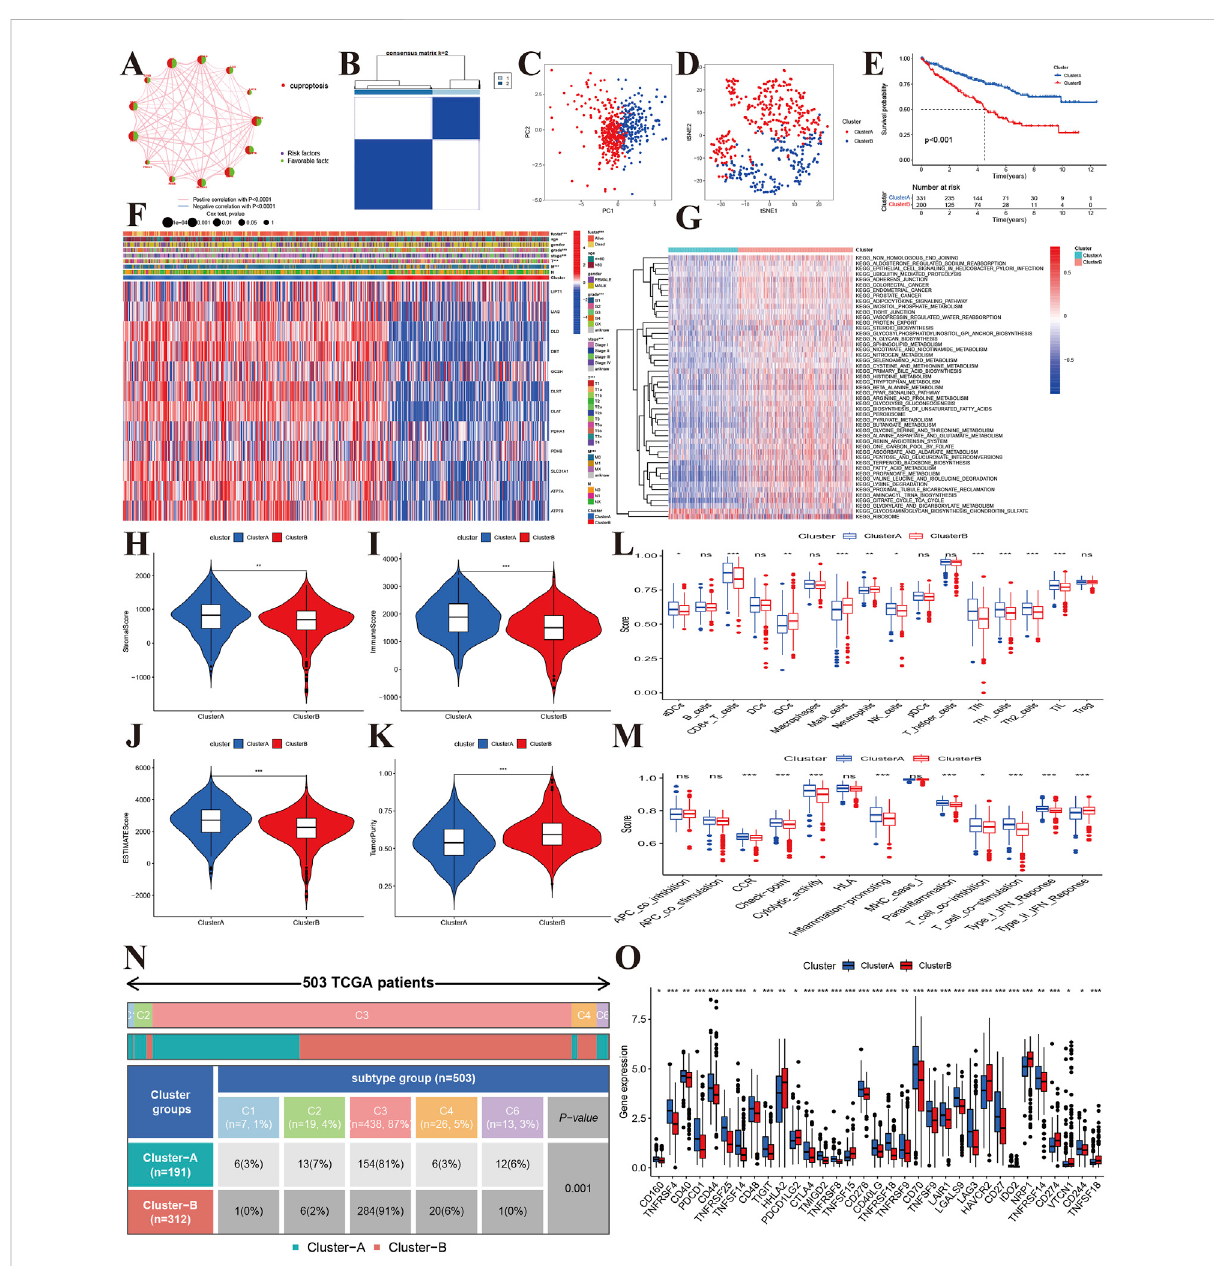
FIGURE 3 MolecularsubtypesbasedoncuproptosisregulatorsinKIRC. (A) :CorrelationsbetweentheprognosisofcuproptosisregulatorsinKIRC. (B) :The consensus matrixidenti fi edtheoptimalnumberofcuproptosis subtypes. (C,D) :PCAand tSENidenti fi edtwocomponents. (E) :Kaplan-Meiersurvival curvesofthetwomolecularsubtypes. (F) :Correlationsofsubtypeswithclinicalcharacteristics. (G) :GSVAidenti fi eddifferentiallyexpressed signaling pathways. (H – K) :Tumormicroenvironmentandtumorpuritylevelsofdifferentsubtypes. (L,M)